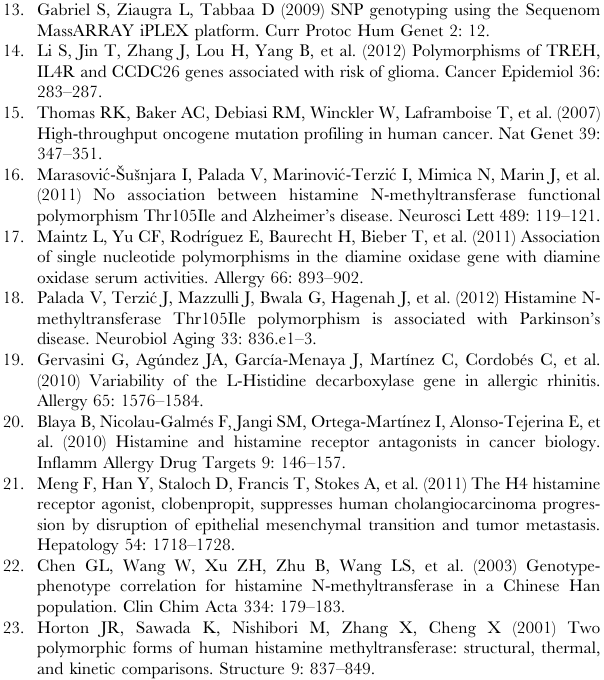
Figure S1 Linkage disequilibrium plot of the SNPs in the HDC gene based on the measure of normalized linkage disequilibrium deviation according to data of Chinese Han population from HapMap. Table S1 Primers used for this study.